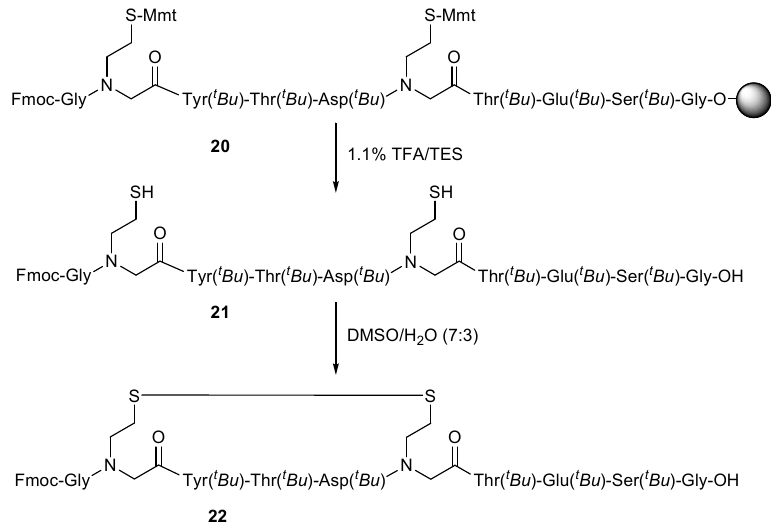
Figure 3. HPLC analysis of peptide–peptoid hybrids: 10 ( A ) (column: Zorbax SB-C18, 3.5 μm; 2.1 × 30 nm; gradient: from 50% to 100% acetonitrile in water within 15 min, 100% acetonitrile within 15 min; flow rate: 0.4 mL/min); 17 ( B ) (column: Lichrospher RP-8 (4 × 150 mm, 5μm); gradient: from 20% to 100% acetonitrile in water within 30 min; flow rate: 1 mL/min); 19 ( C ) (column: Lichrospher RP-8 (4 × 150 mm, 5μm); gradient: from 20% to 100% acetonitrile in water within 30 min; flow rate: 1 mL/min). All chromatograms were detected at 265 nm.